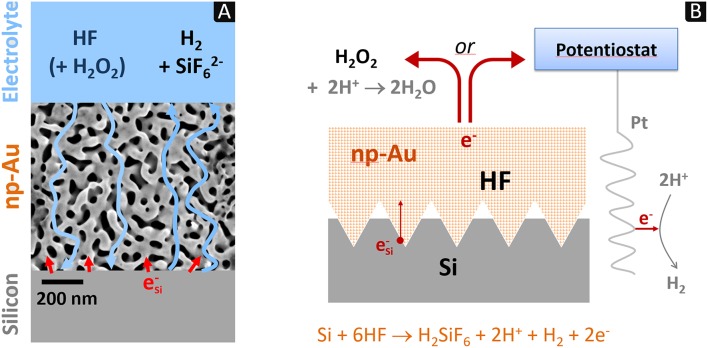
Scheme of the contact etching process: (A) diagram of the fluxes of electrons (red arrows) and chemicals (blue arrows) through a macroscopic piece of np-Au showing the nanometer-scale Au/Si contacts; (B) principle of 3D imprinting of silicon using a np-Au electrode with a pattern consisting in pyramids. Anodic polarization of the electrode can be provided either through an external circuit (electrochemical contact etching) or in situ by H2O2 (chemical contact etching).